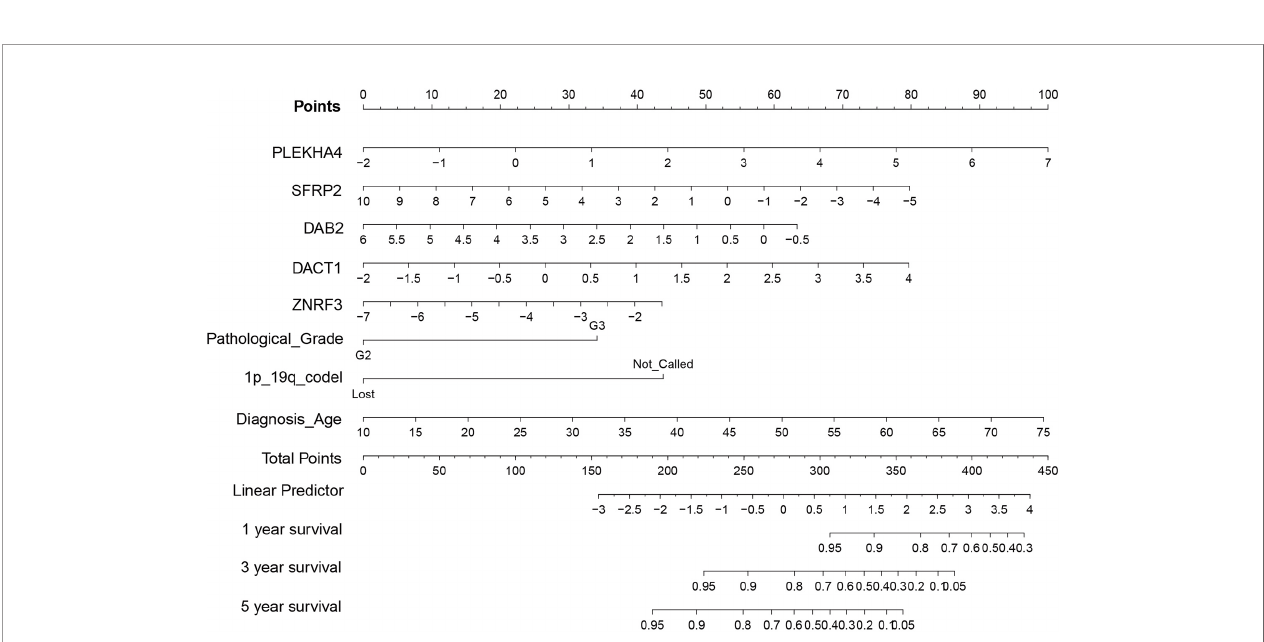
FIGURE 7 | Nomogram of prognostic mode. Given prioritized features and the Cox model, a nomogram consisting of eight variables (PLEKHA4, SFRP2, DAB2, DACT1, ZNRF3, pathological grade, 1p/19q codel, and diagnosis age) was constructed for convenient clinical use.